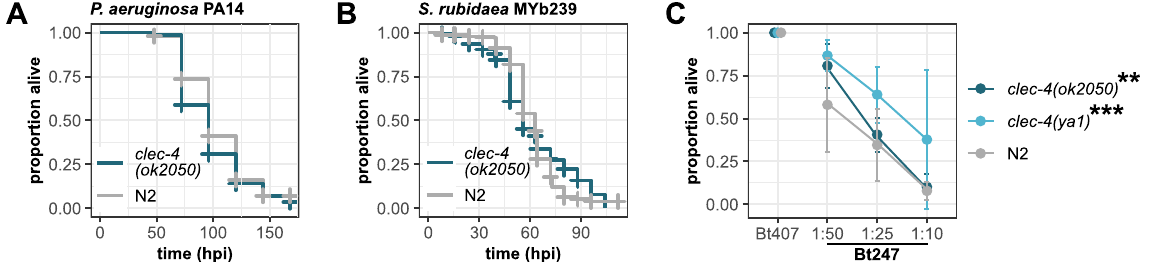
Fig 2. clec-4(ok2050) and clec-4(ya1) increase C . elegans resistance to Bt247 infection. Survival of clec-4(ok2050) and N2 wildtype worms on (A) P . aeruginosa PA14 and (B) S . rubidaea MYb239 over time. (A, B) Alive, dead, and missing worms were scored until all individuals on the pathogen were dead. No significant differences in survival between clec-4 mutants and N2 wildtype worms as determined by Kaplan-Meier analysis [55] and log-rank test [56]. Horizontal ticks represent censored data (missing worms), n = 5, (A) data are representative of two independent experiments, (B) data represent the mean of three independent experiments. (C) Difference in survival on serial dilutions of Bt247 and a dilution of 1:10 of the non-pathogenic Bt407 control 24 hpi (hours post infection) between clec-4(ok2050) , clec-4(ya1) , and N2. Means ± standard deviation (SD) of n = 4 are shown, data are representative of at least four independent experiments. �� p < 0.01, and ��� p < 0.001, according to a generalized linear model (GLM) [57]. Also see S3A and S3B Fig, and S2A and S3A–S3C